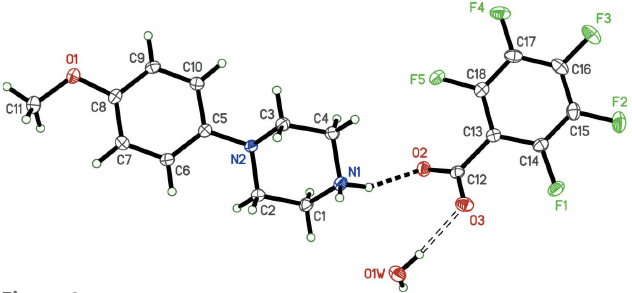
Figure 4 An ellipsoid plot (50% probability) of IV . The solid dashed line denotes an N—H (cid:2)(cid:2)(cid:2) O hydrogen bond, while the open dashed line shows an O— H (cid:2)(cid:2)(cid:2) O hydrogen bond. Hydrogen atoms are drawn as arbitrary